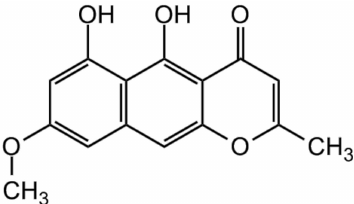
Figure 4. Structure of rubrofusarin. Source: BioViotica